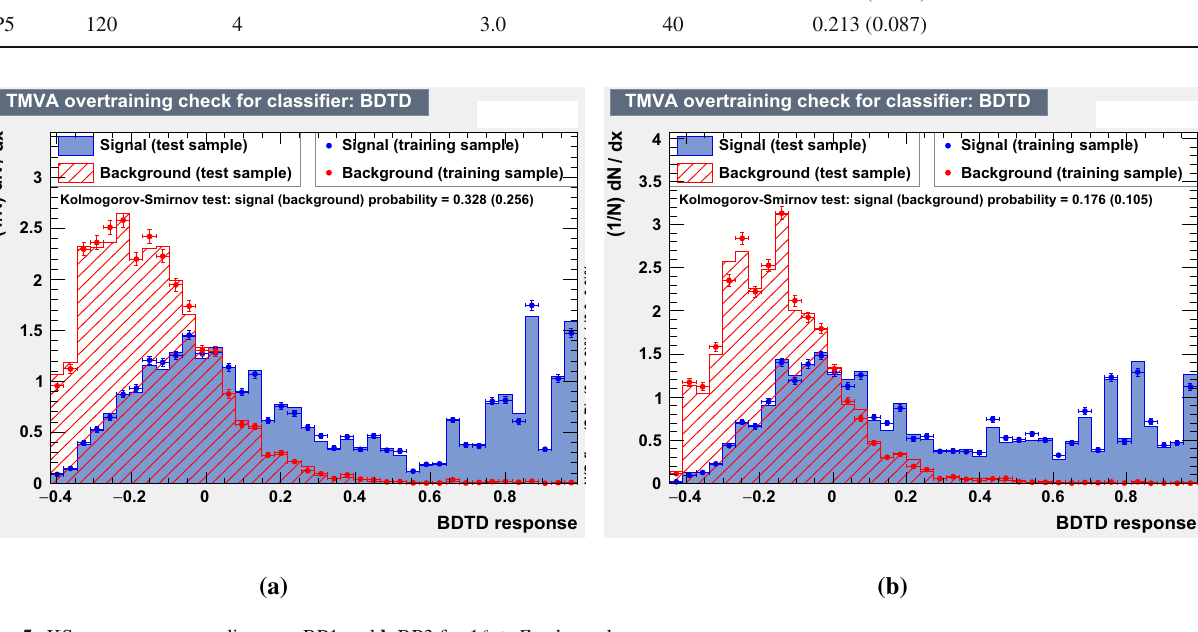
Fig. 5 KS-scores corresponding to a BP1 and b BP3 for 1 (cid:3) + E T / channel